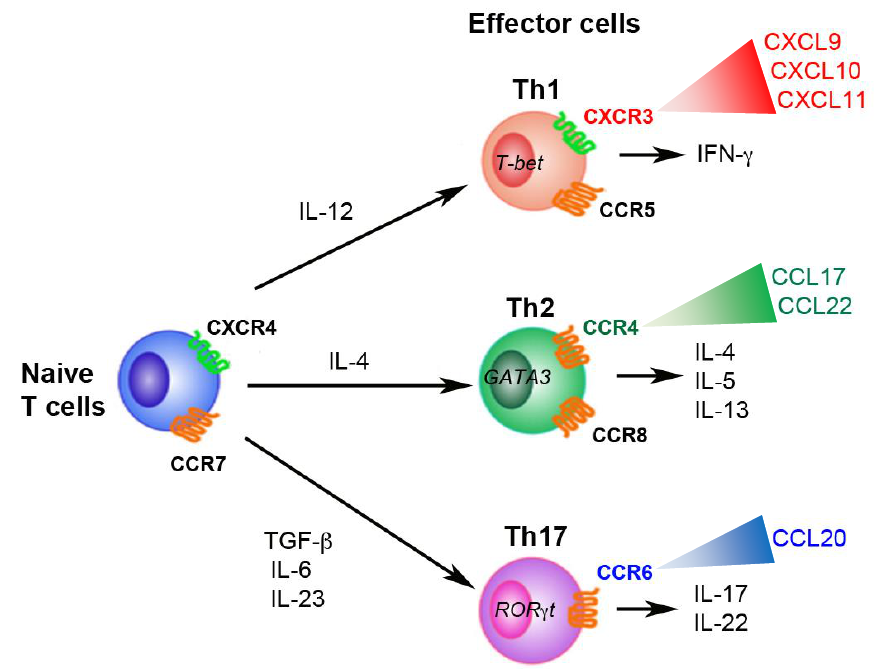
Figure 1. Expression of specific chemokine receptors on CD4 + T cells during their differentiation into effector cells. After antigen stimulation, naïve CD4 + T cells are activated and differentiate into distinct CD4 + Th-cell subsets, depending on the cytokine milieu, which drives a program of differentiation that includes the induction of the expression of key transcription factors as well as specific chemokine receptors. Polarized CD4 + T-cell responses may be amplified by a positive feedback loop involving chemokines. Naïve T cells differentiate into Th1 cells under the direction of the cytokine IL-12 and the transcription factor T-bet. Th1-cell-mediated inflammation is characterized by the recruitment of IFN- γ -producing CD4 + T cells that help protect against intracellular pathogens. The cytokine IL-4 and the transcription factor GATA3 are critical for the differentiation of naïve T cells into Th2 cells. Th2-cell-mediated inflammation is characterized by the recruitment of CD4 + T cells producing IL-4, IL-5, and IL-13 that help to protect against parasites and contribute to allergic responses. CD4 + T-cell populations that exhibit upregulated expression of the transcription factor ROR γ t can differentiate into Th17 cells. Th17-cell-mediated inflammation is characterized by the infiltration of CD4 + T cells that secrete IL-17A, IL-17F, IL-21, and IL-22. Th17 cells are considered to protect against extracellular bacteria and